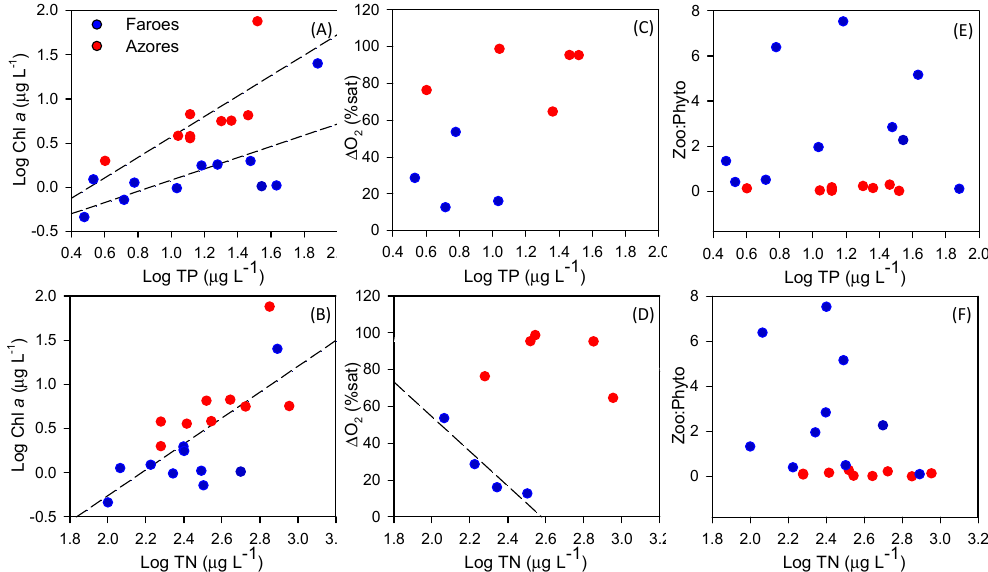
Figure 3. Phytoplankton biomass (as log Chl- a ) versus total phosphorus concentration (as log TP) ( A ), and total nitrogen concentration (as log TN) ( B ); oxygen depletion ( ∆ O 2 %sat) versus log TP in the subset of stratified lakes ( C ) and log TN ( D ); total zooplankton:phytoplankton biomass ratio (zoo:phytobiomass) against log TP ( E ) and log TN ( F ). Red: Azorean lakes, blue: Faroese lakes.